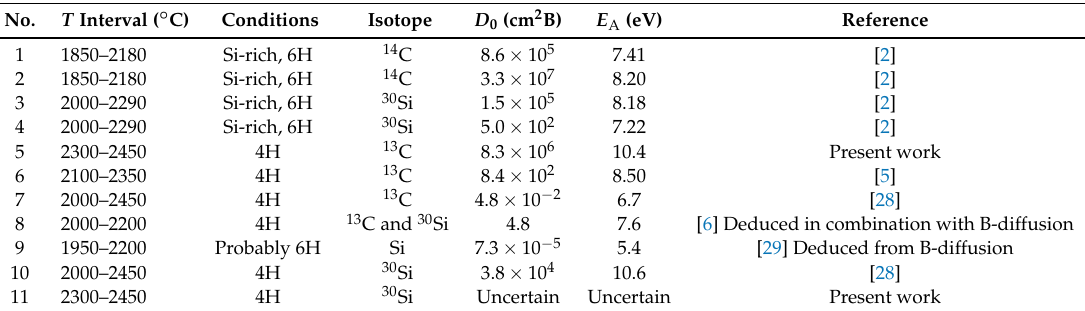
Table 3. Collection of Arrhenius data for C and Si self-diffusion from the literature and the present work (No. 5 and 11), see also Figure